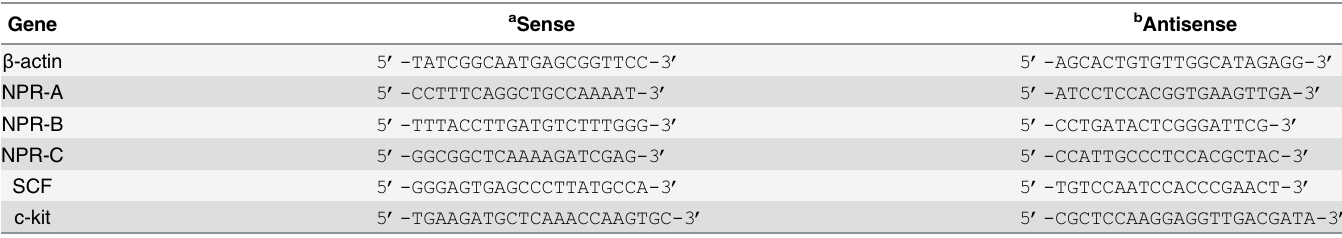
Table 1. Primer sequences used for real time